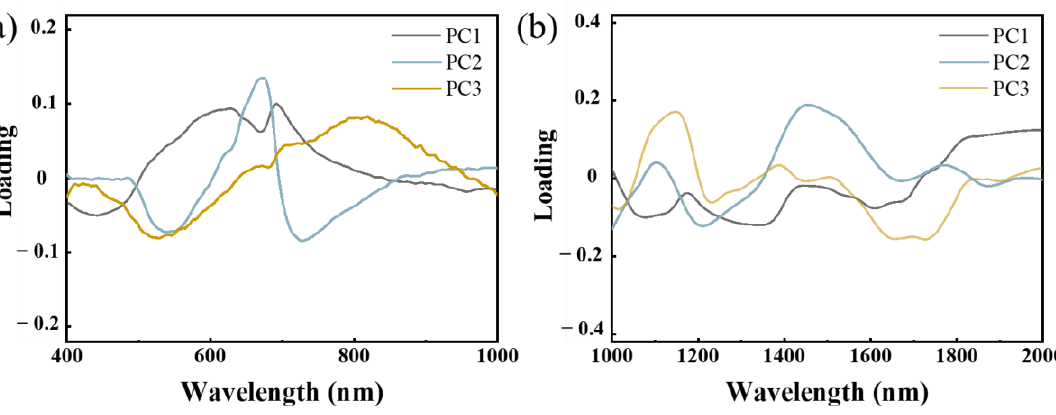
Figure 6. The loading plots of PC1, PC2 and PC3 in the range of ( a ) 400 – 1000 nm and ( b ) 1000 – 2000